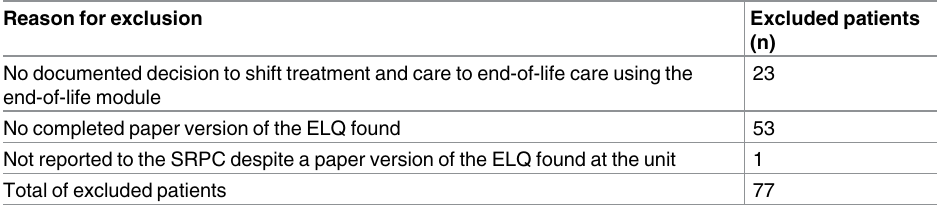
Table 1. Number of excluded patients and reasons for